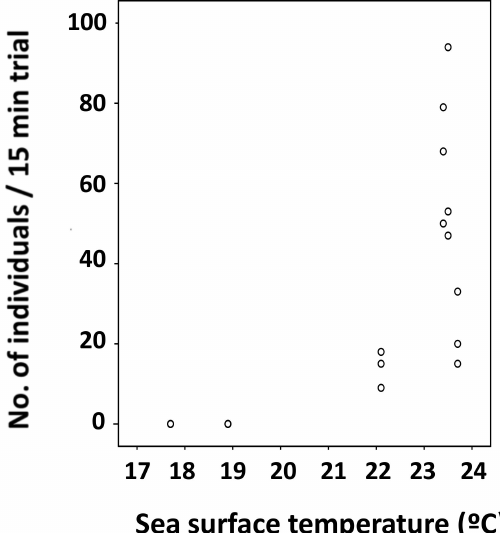
Figure 5. Relationship between sea surface temperature at the collection sites and the individual number of Halobates sericeus specimens collected on the route (Tokyo–Honolulu) during the cruise KH-12-01-Leg 2 in February and March 2012.